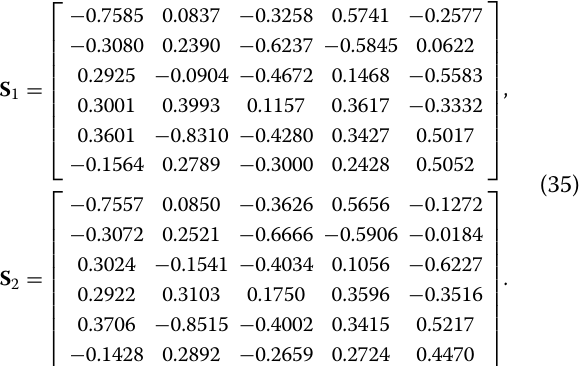
Table 1 The joint beamforming and power control update algorithm 1. Initial data: beamforming vectors ˆ u k , power control p k , channel matrices H k , and target SINRs γ ∗ and tolerance ε .